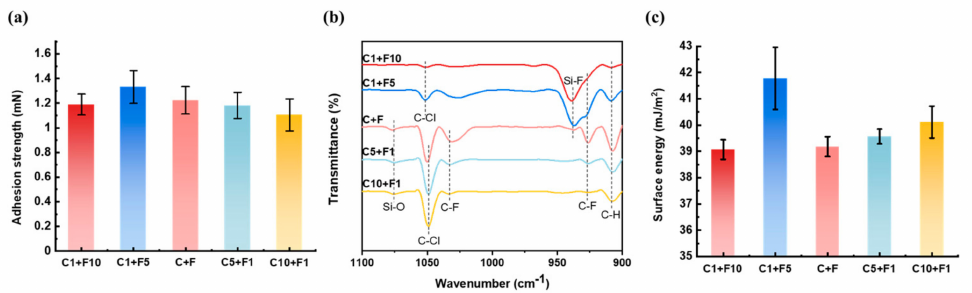
Figure 3. Comparison of the Parylene copolymer films with different dimers mass ratios of Parylene C and Parylene F. ( a ) Adhesion strength. ( b ) FTIR results with wavenumber from 1100 to 900 cm − 1 . ( c ) Surface energy results calculated from the contact angles measurements with DI water and methanol. The generated Si–F bond and change in surface energy explained the principles of the adhesion strength enhancement by the Parylene copolymerization